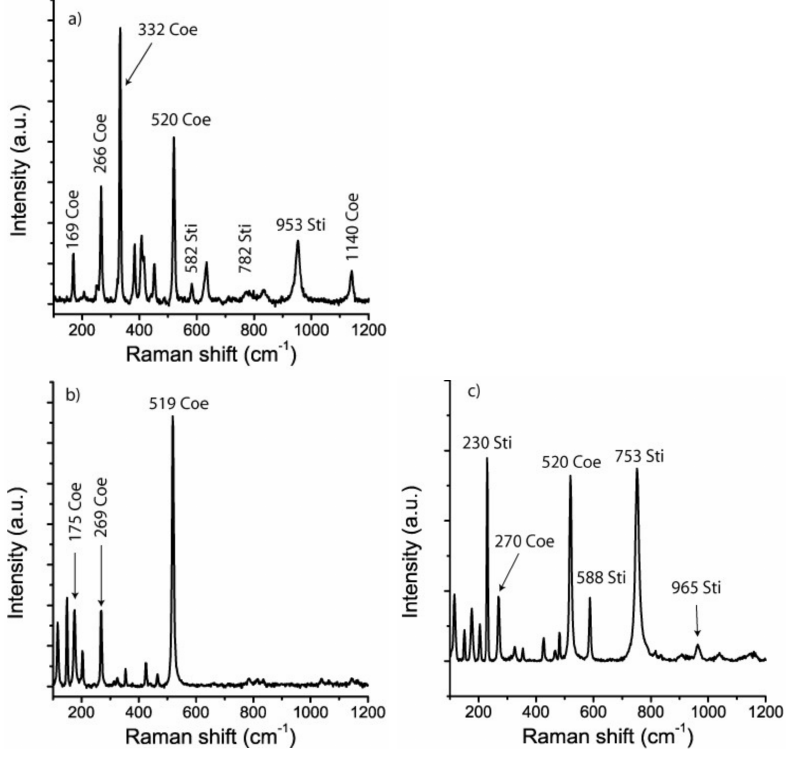
Figure 3. Raman spectra of the Waldheim coesite ( a ) together with synthetic coesite from the coesite and coesite-stishovite fields ( b , c ). Coe—coesite,